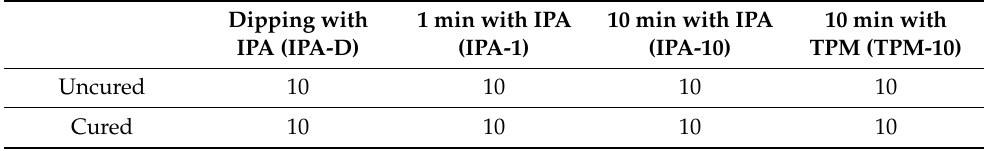
Table 2. Experimental groups according to washing